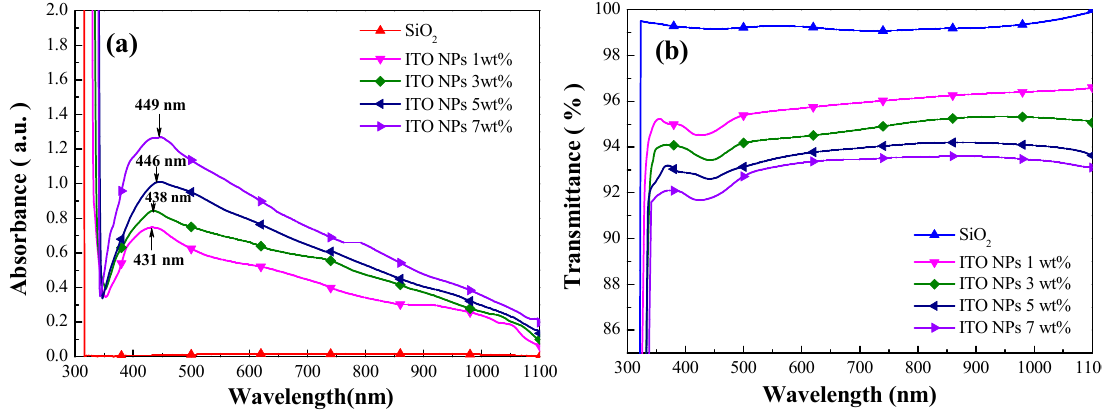
Figure 5. ( a ) The absorbance spectra of ITO NPs dispersed in the SiO 2 layer at a concentration of 1, 3, 5, or 7 wt%; ( b ) optical transmittance of ITO NPs dispersed in the SiO 2 layer at a concentration of 1, 3, 5, or 7 wt%.